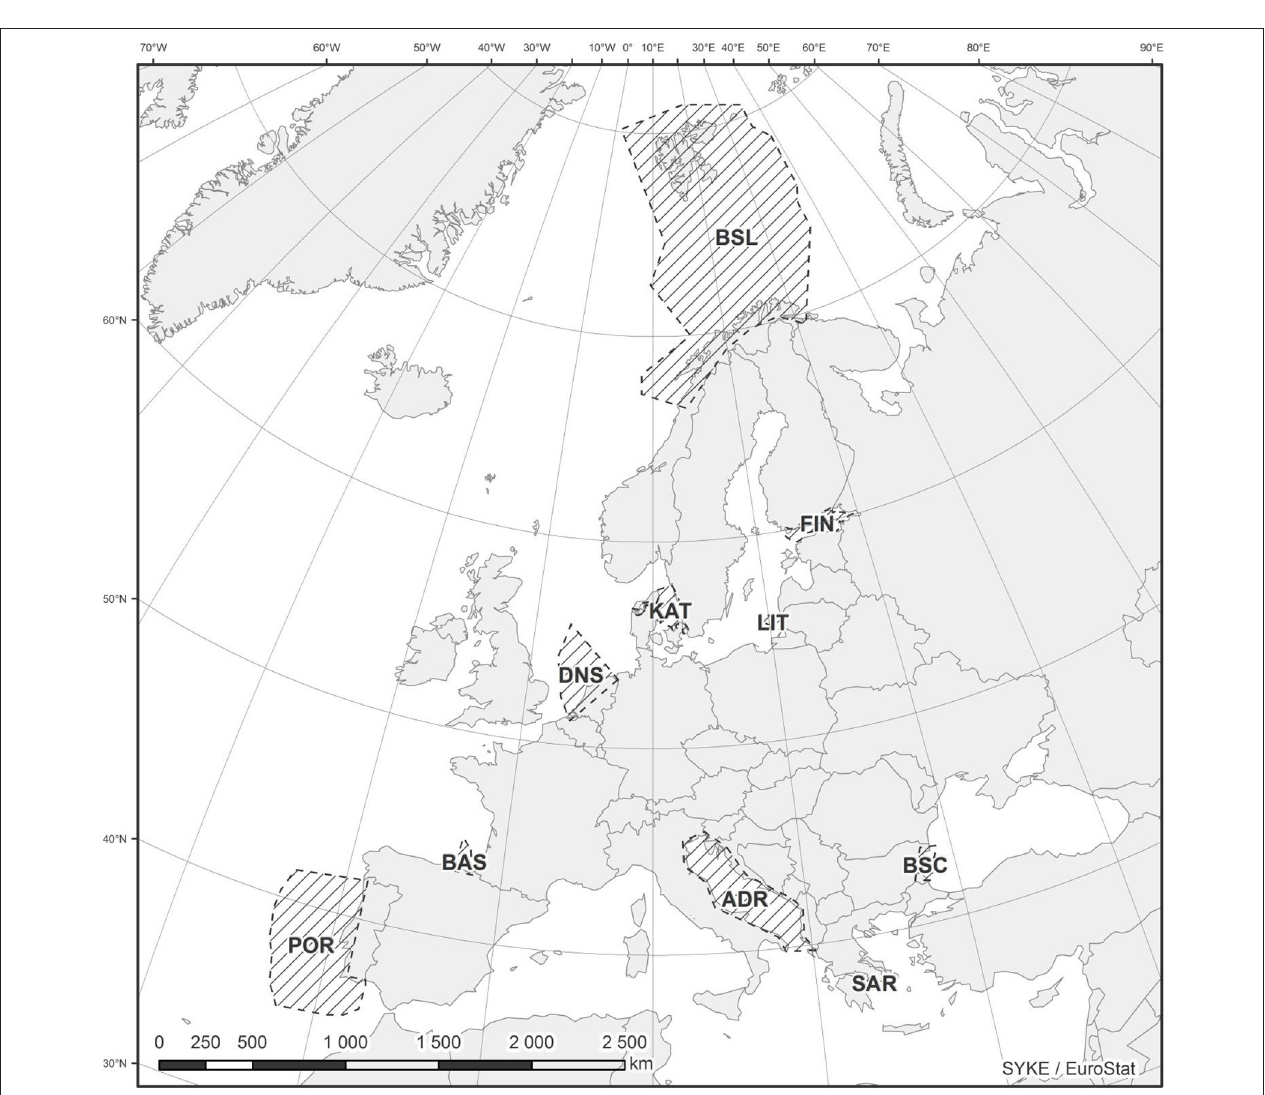
FIGURE 1 | The case study areas. For the area codes, see Table 1 . More detailed case study maps can be found in Supplementary Material (S1–S10).